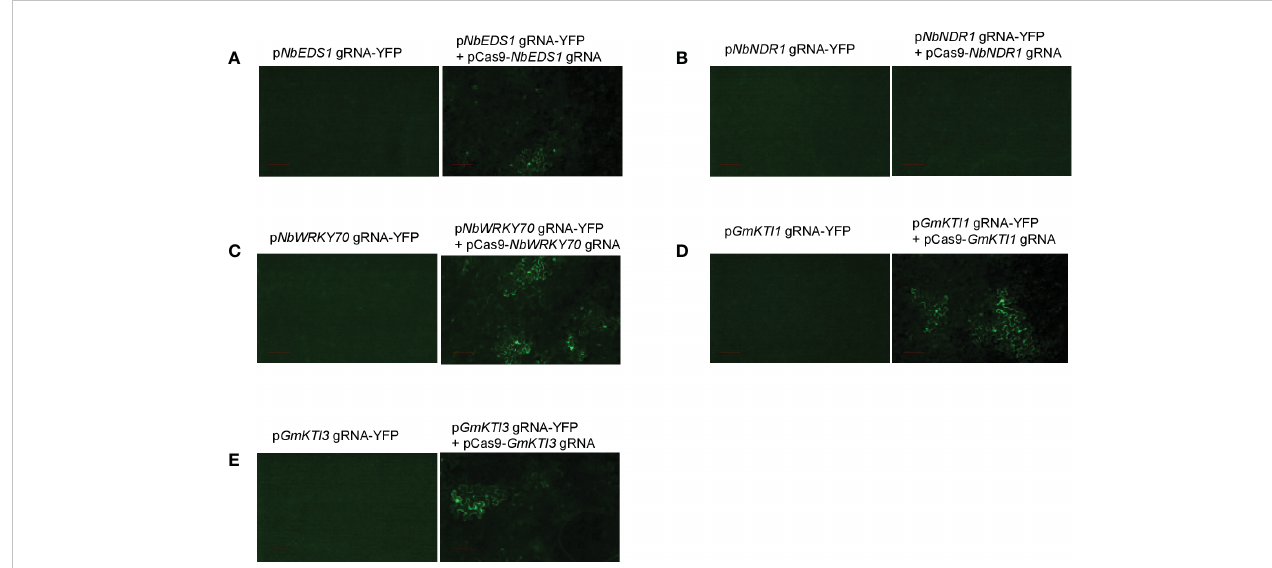
FIGURE 4 The pgRNA-YFP vectors are used to screen the effectiveness of gRNAs in Agrobacterium -mediated transient assays. Transient expression of pgRNA-YFP alone in N. benthamiana does not produce any fl uorescent signals. (A) Co-expression of p NbEDS1 gRNA-YFP with pCas9- NbNDR/NbEDS1 gRNA restored the YFP signals in N. benthamiana . (B) Co-expression of p NbNDR1 gRNA-YFP with pCas9- NbNDR1/NbEDS1 gRNA failed to restore the YFP signals. (C) Co-expression of p NbWRKY70 gRNA-YFP with pCas9- NbWRKY70 gRNA restored the YFP signals. (D, E) Co-expression of either p GmKTI1 gRNA-YFP or p GmKTI3 gRNA-YFP with pCas9- GmKTI1/GmKTI3 gRNA restored the YFP signals in N. benthamiana . Scale bar represents 100